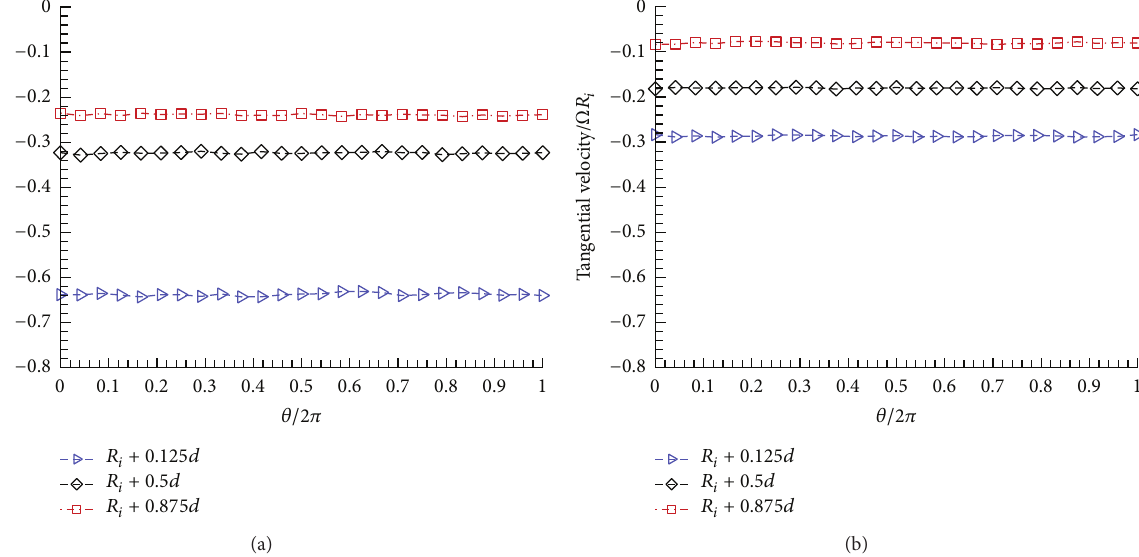
Figure 6: Azimuthal profiles of normalised tangential velocity at different radial heights on selected axial planes for the test cases (a) Γ = 11.36 and (b) Γ = 7.81